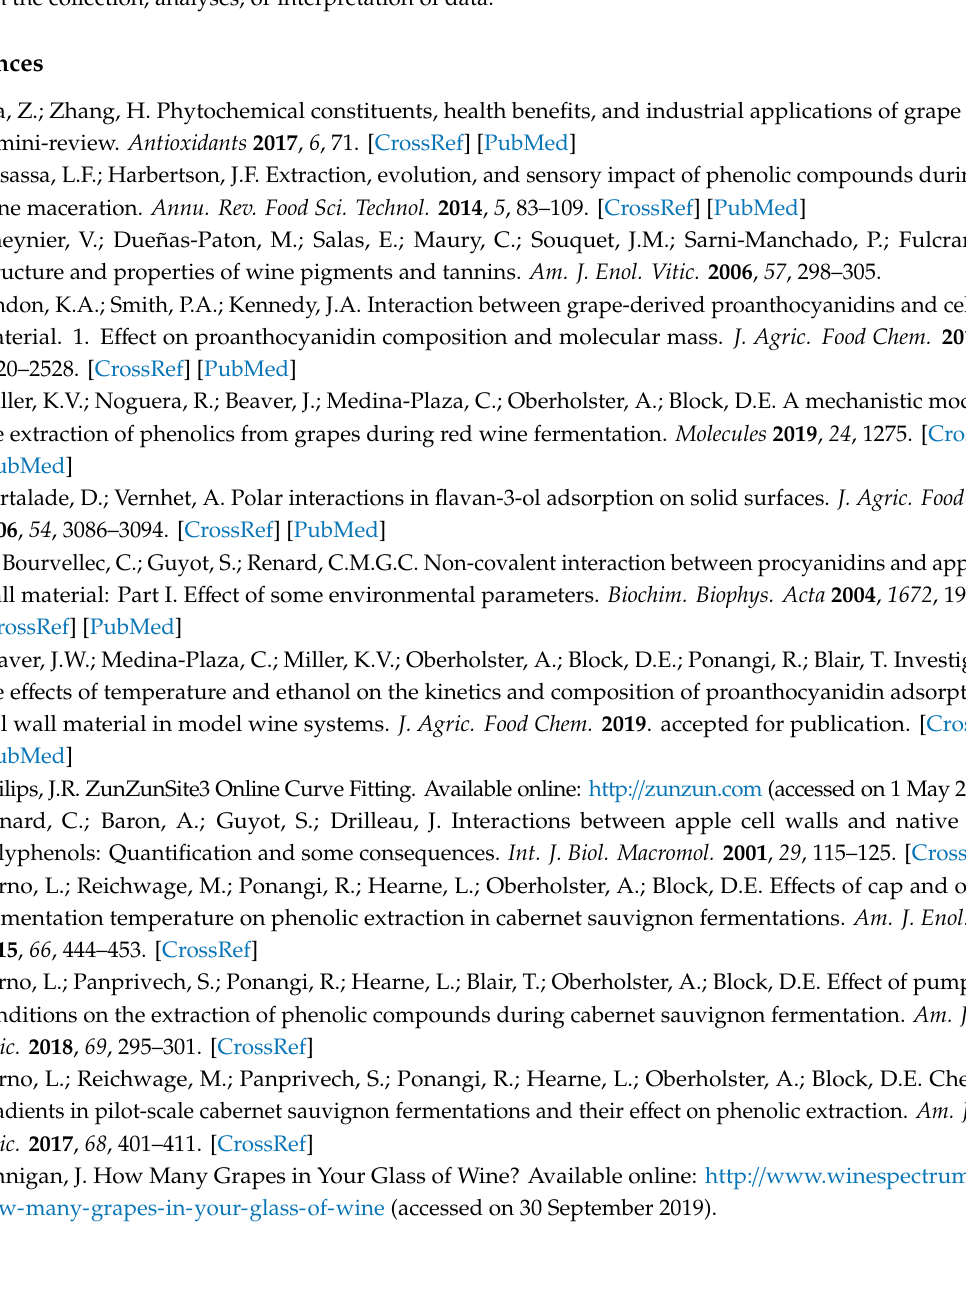
Supplementary Materials: Figure S1. Adsorption data points from individual conditions and Langmuir isotherms constructed from calculated values of Equation 2 and 3 in model wine systems of 0% ethanol ( v / v ). Figure S2. Adsorption data points from individual conditions and Langmuir isotherms constructed from calculated values of Equation 2 and 3 in model wine systems of 7.5% ethanol ( v / v ). Figure S3. Adsorption data points from individual conditions and Langmuir isotherms constructed from calculated values of Equation 2 and 3 in model wine systems of 12% ethanol ( v / v ). Figure S4. Adsorption data points from individual conditions and Langmuir isotherms constructed from calculated values of Equation 2 and 3 in model wine systems of 15% ethanol ( v / v